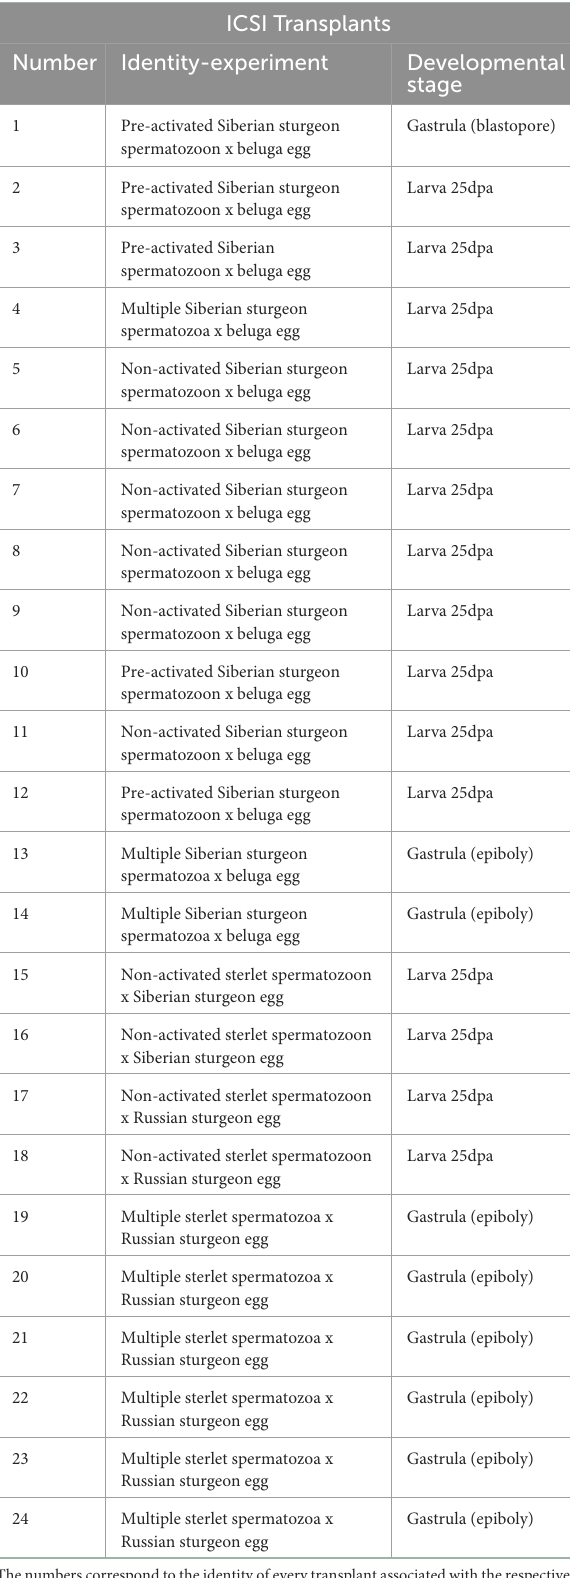
TABLE 2 Information of transplants after ICSI experiments with fresh-stripped spermatozoa used for the molecular analysis. ICSI